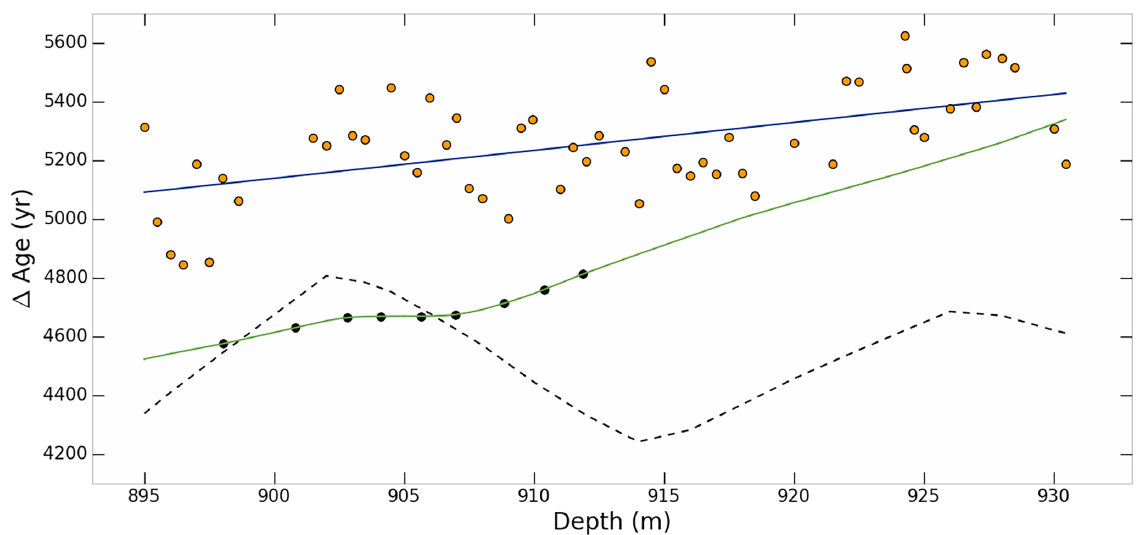
Figure 2. (cid:49) Age along the Vostok record. Orange dots: (cid:49) Age directly estimated from δ 15 N measurements. In blue: (cid:49) Age derived from the linear regression on isotopic measurements. Black dashed line: (cid:49) Age as given by AICC2012. In green: (cid:49) Age after matching with the WDC CH 4 record. Black dots: tie points (minima, maxima, and mid-slope points) used to match the WDC record (see Sect. 5.2).